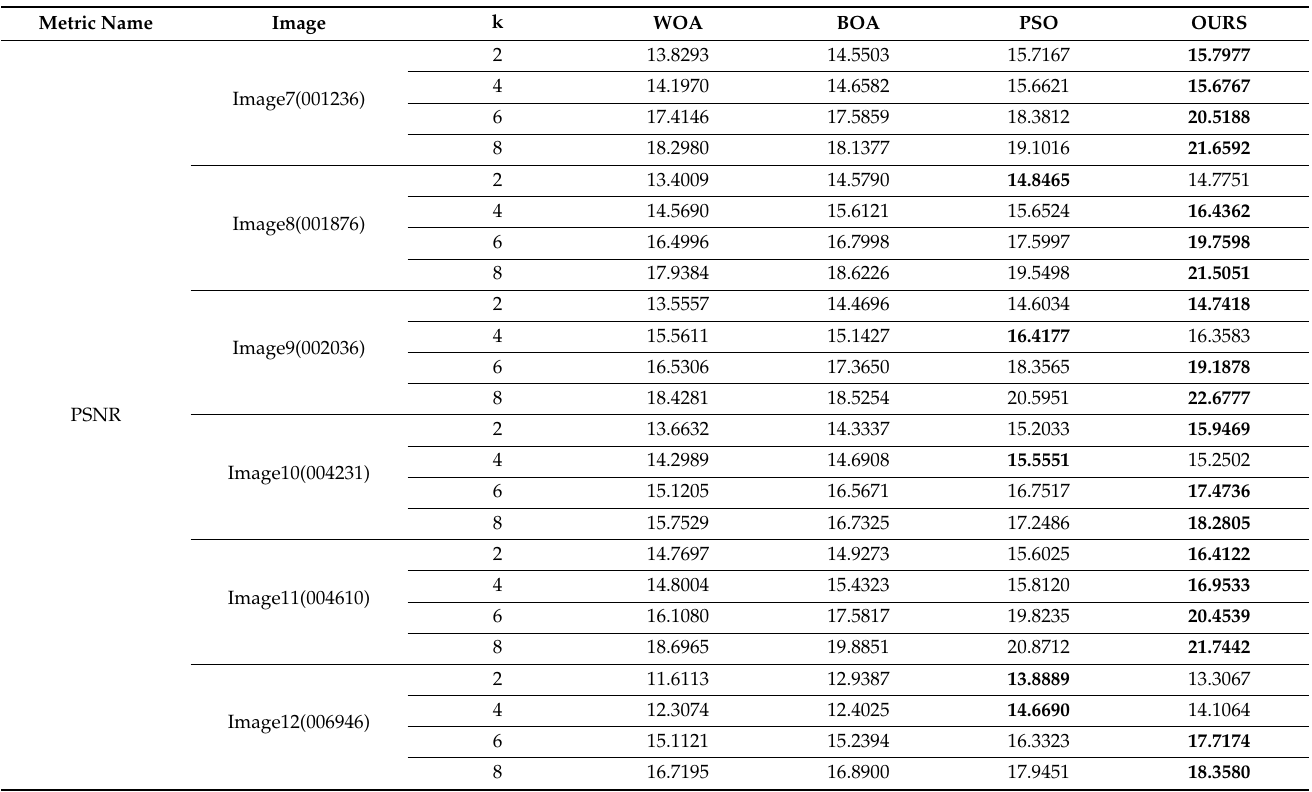
Table 7. Comparison of PSNR in Images g–l.